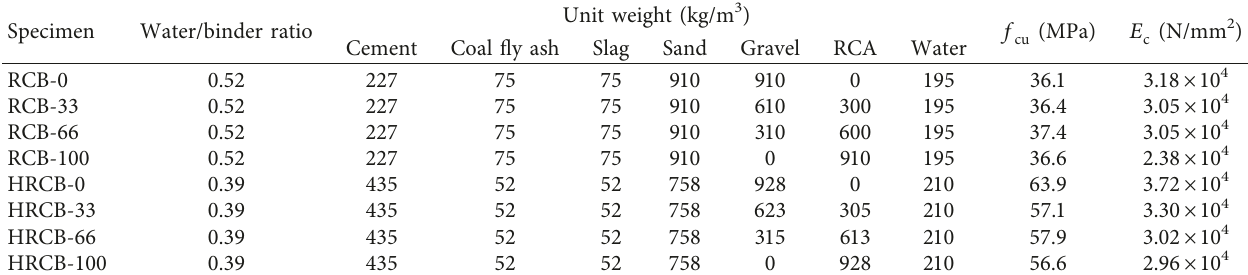
Table 3: Mix proportions of concrete.